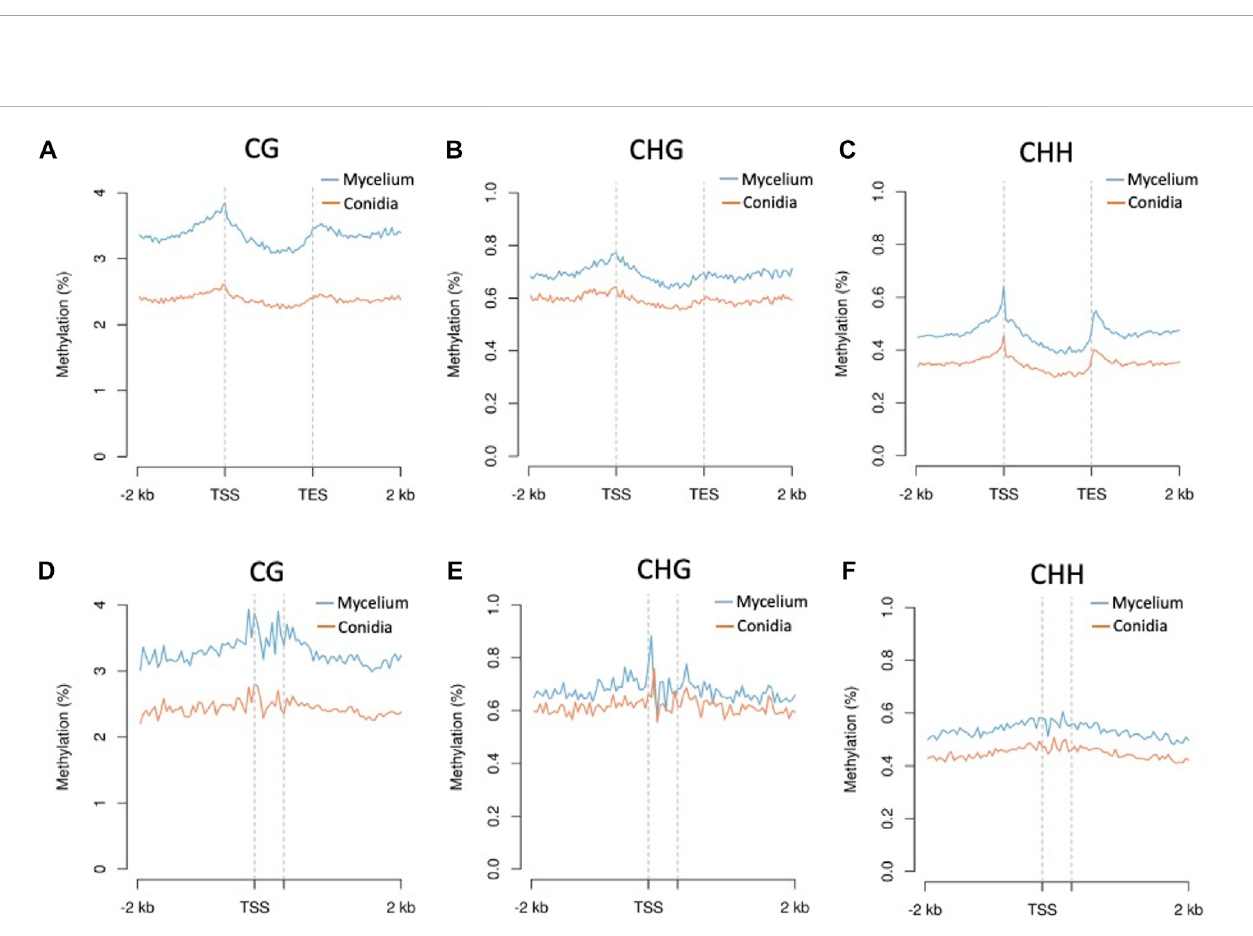
FIGURE 4 Methylation levels of the CG, CHG, and CHH contexts of conidia and mycelium in the Bb-NCHU-157 genome. Densities of the CG, CHG, and CHH contexts around genes and transposons are shown using MetaPlot. Conidial and mycelial methylation levels around genes (A – C) and transposable elements (D – F) . TSS, transcription start site and TES, transcription end